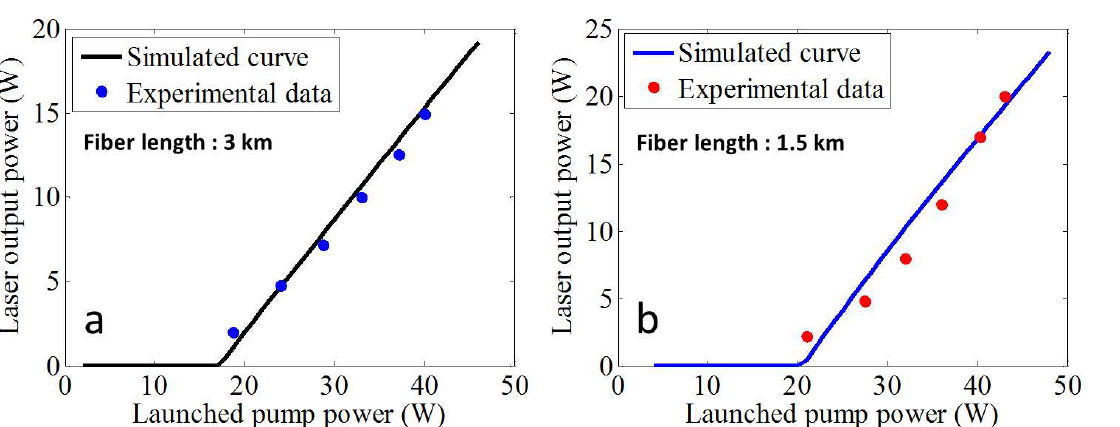
Figure 3. Simulated and experimental CW FRL output power against the launched pump for GRIN-MM fiber lengths of 3 km ( a ) and 1.5 km ( b